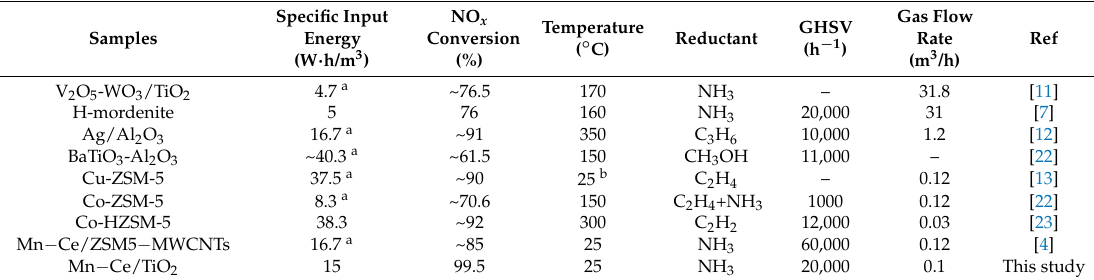
Table 1. Plasma-catalyst performance in previous